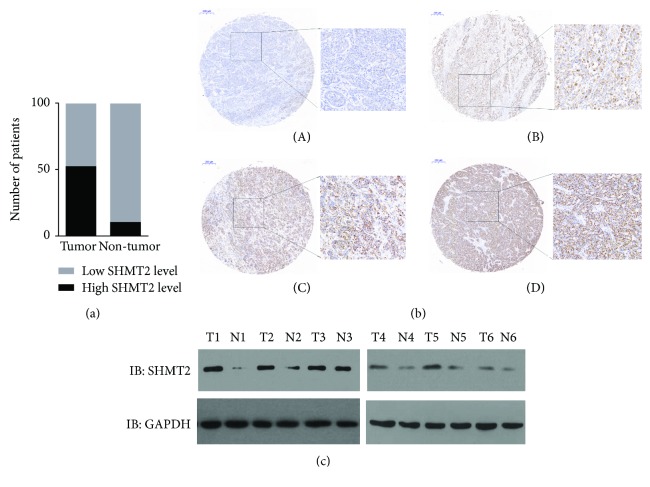
(a) SHMT2 expression is higher in tumor than in paired nontumor tissue. IHC score results demonstrated that high SHMT2 expression was observed in 52 of the 100 tumor specimens while only 15 of the paired nontumor tissue showed SHMT2 high expression. (b) SHMT2 expression patterns in intrahepatic cholangiocarcinoma. A: negative staining (−), B: weakly positive staining (+), C: positive staining (++), and D: strongly positive staining (+++). Round photographs represent TMA cores, and quadrate photographs represent specific areas from TMA cores at magnification 200x. (c) SHMT2 protein level is significantly higher in representative tumor tissue than in paired nontumor tissue. Representative Western blot images from three independent experiments are shown. T means tumor and N means paired nontumor.